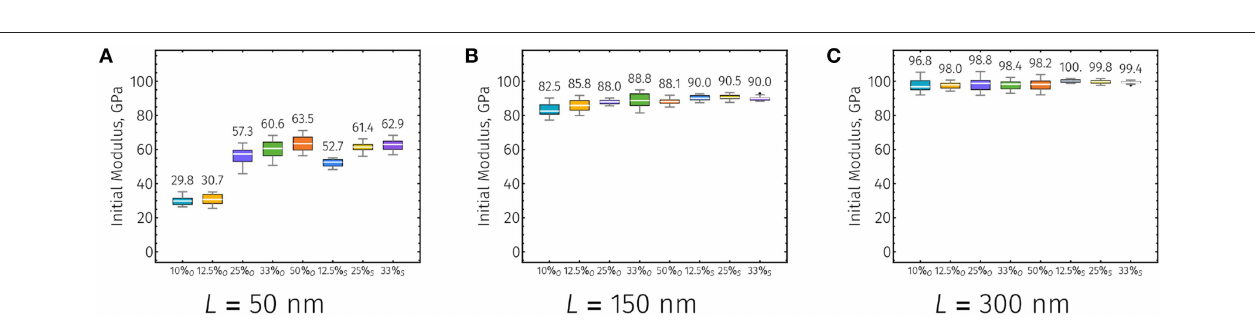
FIGURE 4 | Initial and deformed configurations of various sized [ (A,B) L = 50nm, (C,D) L = 150nm, and (E,F) L = 300nm] and arranged [ (A,C,E) 50% regular and (B,D,F) 33% staggered offset between neighboring fibers] two dimensional CNC films. Locations of chain rupture are indicated by red circles in deformed structures.